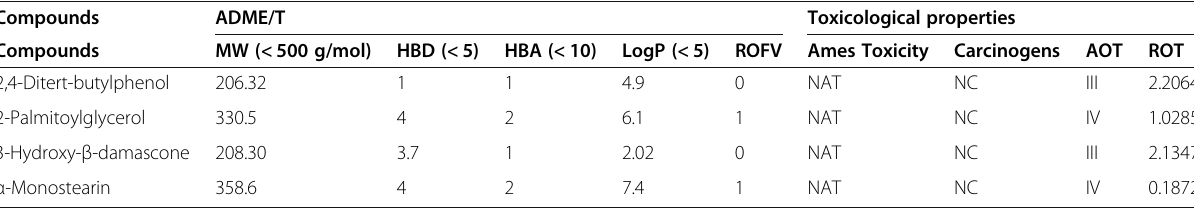
Table 5 ADME/T and toxicological properties prediction of the bioactive compounds Compounds ADME/T Toxicological properties Compounds